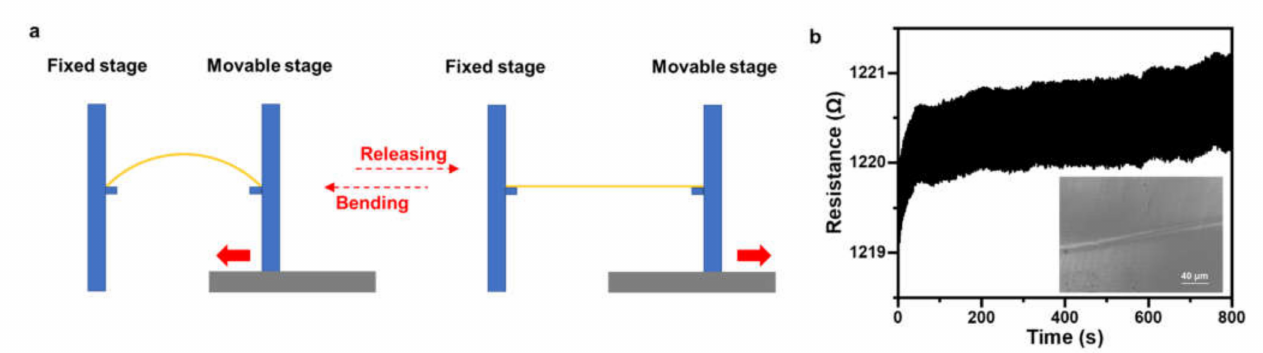
Figure 8. ( a ) Schematic diagram of the experimental setup for the repeated bending test. ( b ) Resistance recorded for an angle sensor during 800 cycles of repeated bending. Inset: SEM image of the surface morphology of the Pt wire after bending